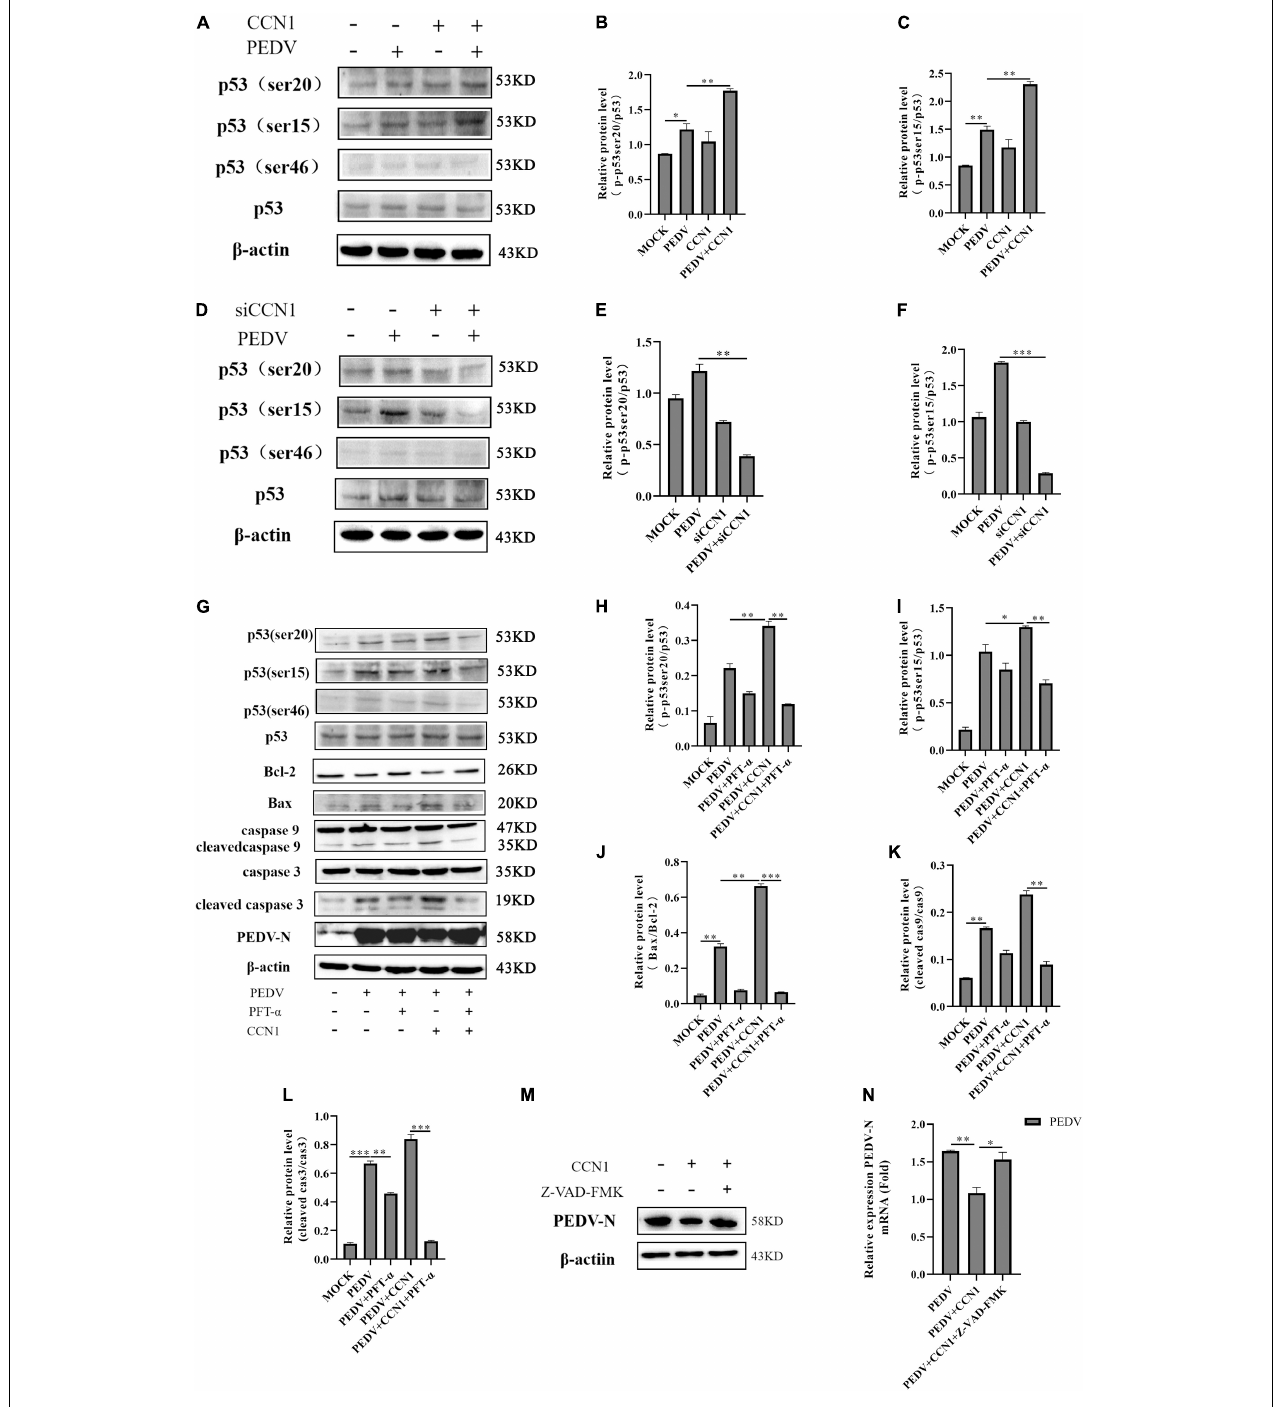
FIGURE 9 | The role of p53 in CCN1-mediated apoptosis. (A–C) Marc-145 cells were transfected with pcDNA3.1-CCN1-his or pcDNA3.1-his vector for 36 h and then with or without the PEDV strain to infect cells for 24 h; Western blot was used to detect the abundance of the p53, phospho-p53(ser15), phospho-p53(ser20), and phospho-p53(ser46). (D–F) Marc-145 cells were transfected with siNC or siCCN1 for 48 h and then with or without the PEDV strain to infect cells for 24 h; Western blot was used to detect the expression of the p53, phospho-p53(ser15), phospho-p53(ser20), and phospho-p53(ser46). (G–L) Marc-145 cells were transfected with pcDNA3.1-CCN1-his or pcDNA3.1-his vector for 36 h, using pretreated PFT- α 1 h before infecting with PEDV; Western blot analyzes caspase 9, cleaved caspase 9, caspase 3, cleaved caspase 3, Bax, Bcl-2, PEDV-N, p53, and phosphorylated p53 expression levels. (M,N) Marc-145 cells were transfected with pcDNA3.1-CCN1-his or pcDNA3.1-his vector for 36 h, using pretreated Z-VAD-FMK 1 h before infecting with PEDV; Western blot analyzes PEDV expression levels. The data were performed from three independent experiments. The differences were evaluated using Student’s t -test, and significance differences were denoted by ∗ p < 0.05, ∗∗ p < 0.01, and ∗∗∗ p < 0.001.